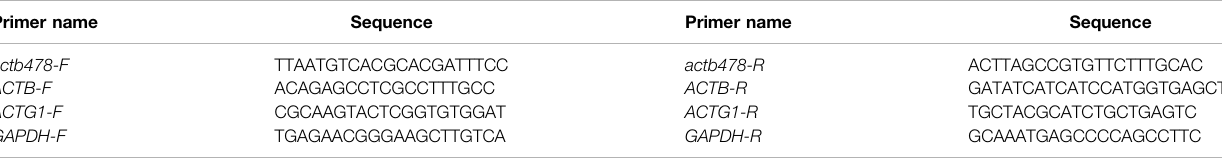
TABLE 1 | PCR and Sanger sequencing primers (5 ′ – 3 ′